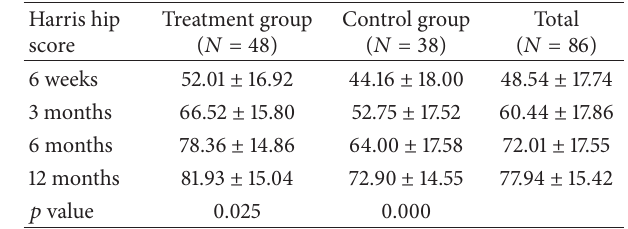
Table 2: Comparisons of the mean Harris hip scores at each time point.